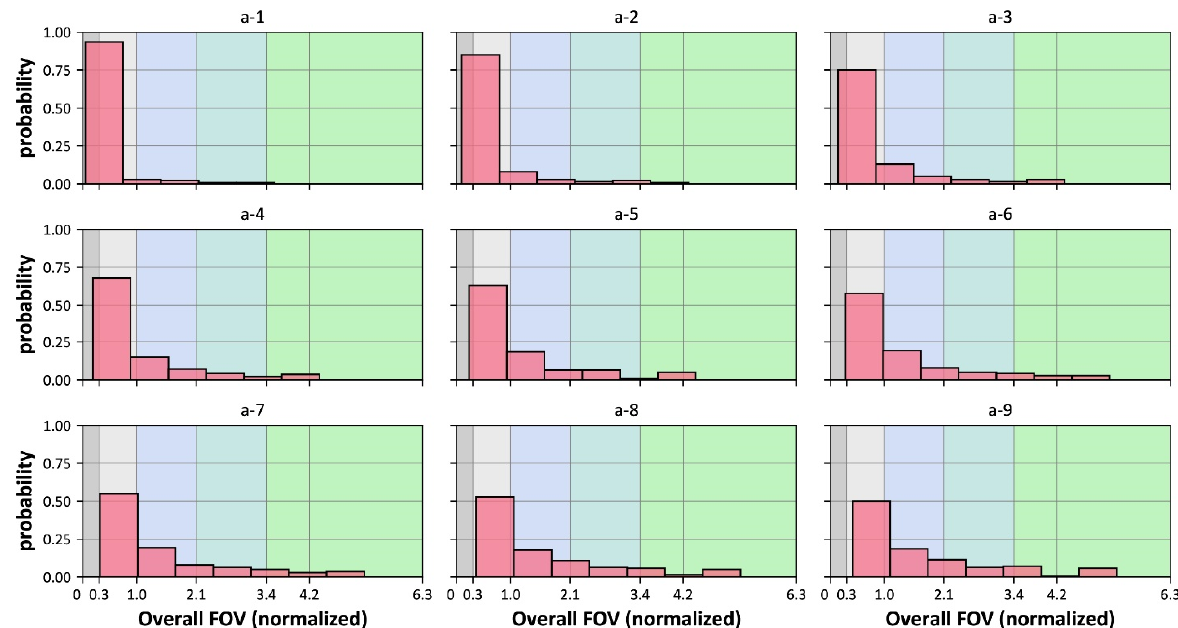
Figure 7. Examples of view access in false color maps in terms of computed overall, horizontal, and vertical FOVs in scenario-a, including case studies with different window sizes.